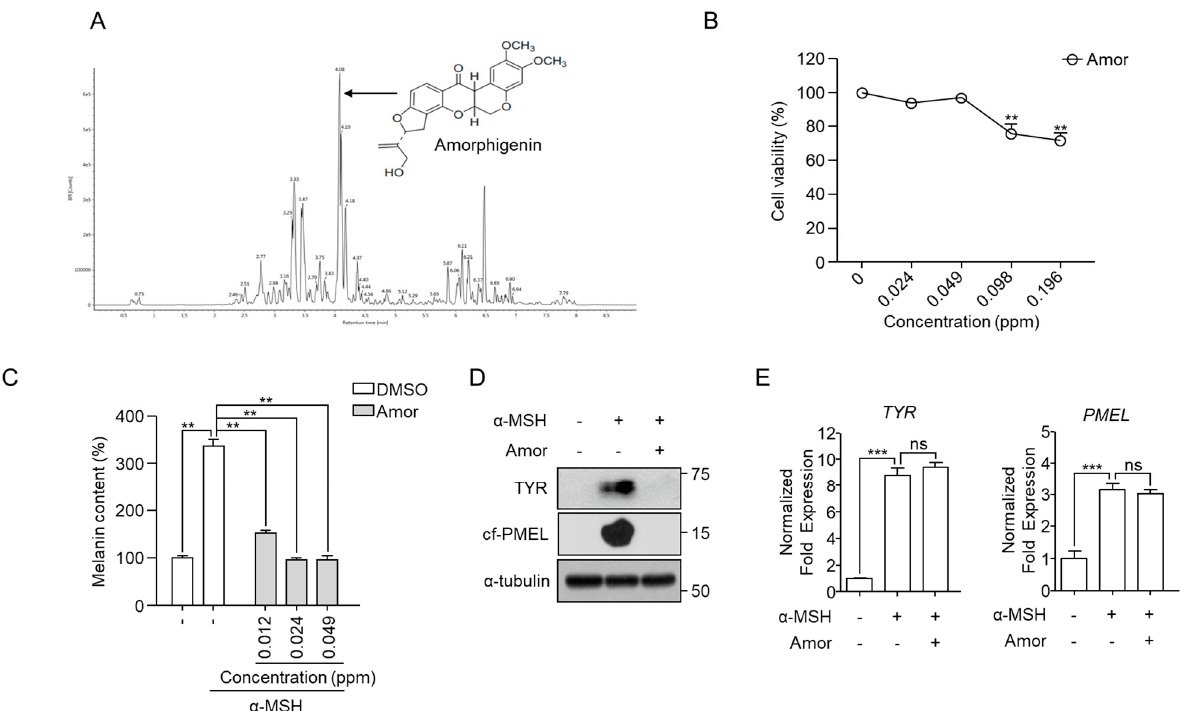
Figure 3. Amorphigenin as a functional metabolite in A. fruticosa L. RE-mediated depigmenta- tion. ( A ) Chromatographic analysis of A. fruticosa RE using Vion UPLC-ESI-Q-TOF/MS system. ( B ) B16F10 cells were treated with various concentrations of amorphigenin (Amor) for 48 h, and cell